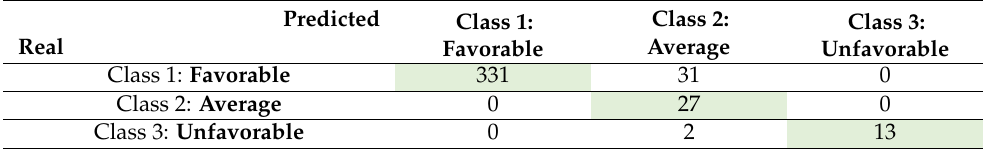
Table 6. Confusion matrix for the HMP-Coffee model. The Predicted columns correspond to the estimated profitability (Favorable, Average, and Unfavorable). Real rows columns correspond to the profitability of the ICAFE test dataset (Favorable, Average, and